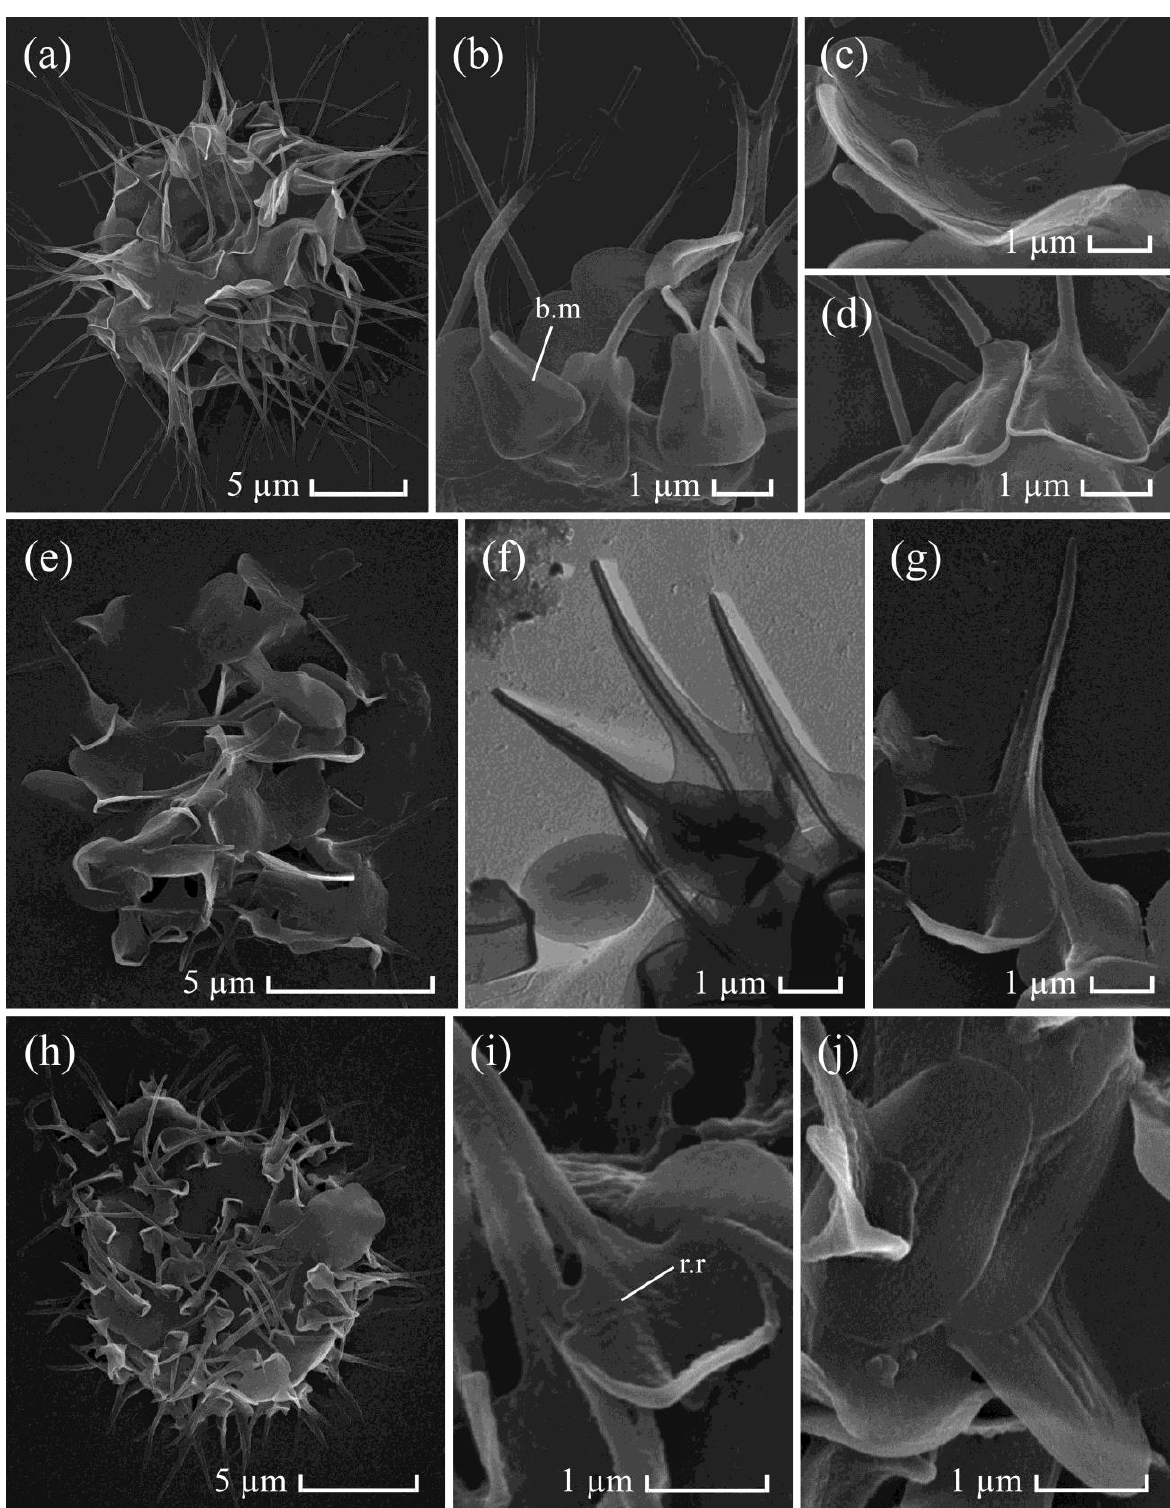
Figure 5. Morphology of observed scales of centrohelid genus Pterocystis , (a)–(e) and (g)–(j) SEM, (f) TEM. (a)–(d) P. anapoda : (a) scales of a single cell; (b) spine scales; (c) plate scales; (d) basal membrane of spine scales. (e)–(g) P. pinnata : (e) scales of single cell; (f) spine and plate scales; (g) spine scales. (h)–(j) P. tropica : (h) scales of a single cell; (i) basal membrane of spine scale; (j) plate scales and basal membrane of spine scale. Abbreviations: b.m = basal membrane. Other abbreviations as in Figure